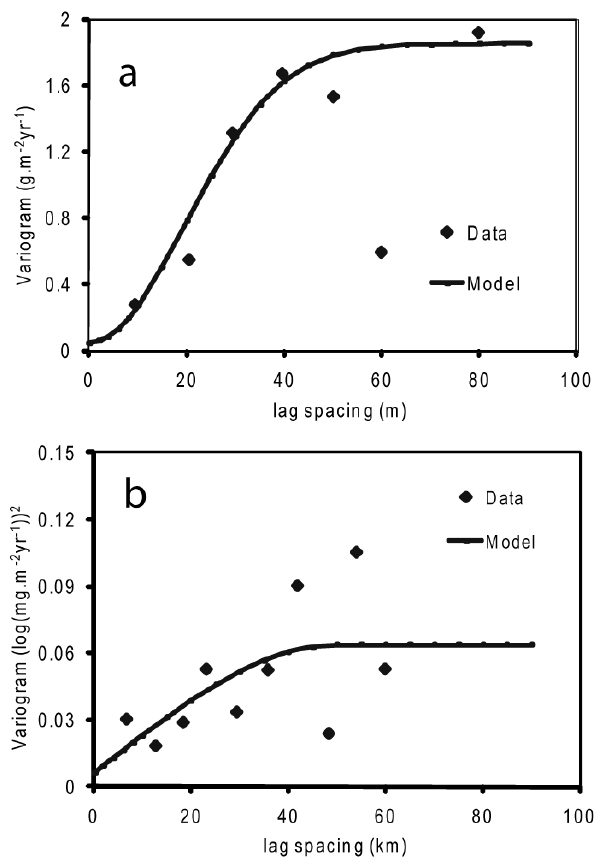
Fig. 4. Calculated variograms and the model fittings for (a) ob- served annual bulk chloride deposition, and (b) regression de- trended log D residuals over the 17 sites. The fitted model is a Gaussian model (range = 48km, sill = 1.8 (gm − 2 ) 2 , and nugget = 0.05 (gm − 2 ) 2 ) for (a), and a spherical model (range = 50km, sill = 0.058, and nugget = 0.006 for (b).